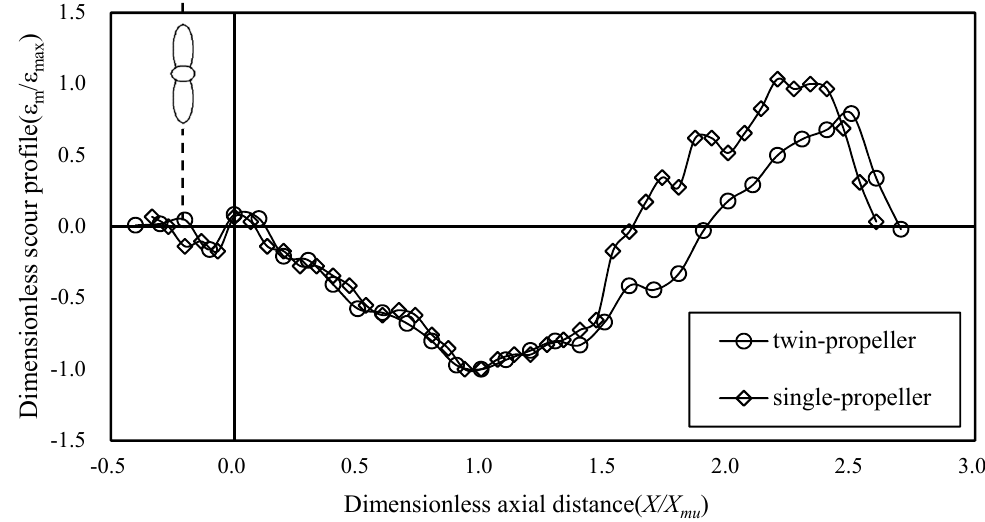
Figure 12. Scour induced by a twin-propeller and single-propeller.